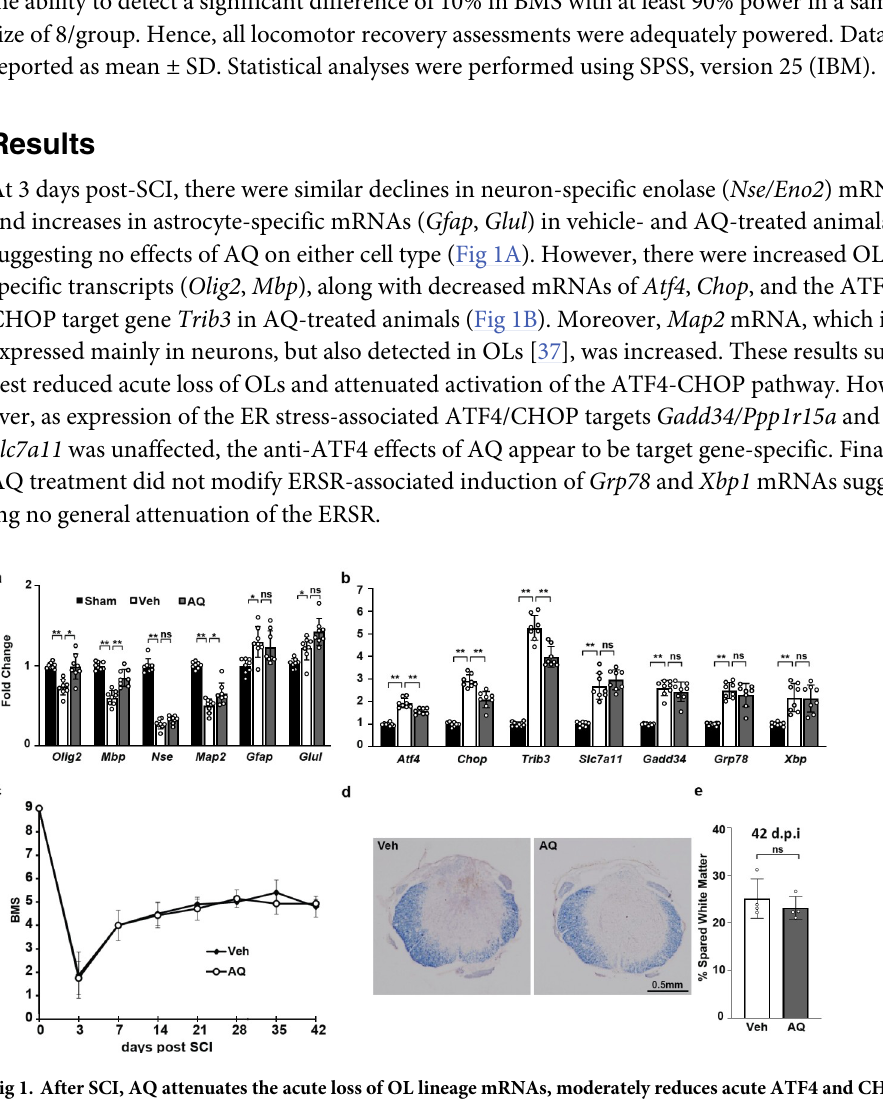
Fig 1. After SCI, AQ attenuates the acute loss of OL lineage mRNAs, moderately reduces acute ATF4 and CHOP activation, but does not improve chronic functional locomotor recovery. (a) neural cell-specific and (b) ISR/ERSR and ATF4-regulated gene mRNA levels 72 hours-post SCI. Transcript levels (normalized to Gapdh ) are expressed as fold change sham controls. Data in (a, b) are the mean ± SD (n = 8, � p < 0.05; �� p < 0.01; ns, p > 0.05, u -test). (c) BMS analysis of hindlimb locomotion revealed no significant differences in hindlimb locomotor recovery between vehicle (Veh)- (n = 6) and AQ-treated 30 mg/kg (n = 7) mice (repeated measure two-way ANOVA showed significant effects of time after injury /F 5,21 = 12.34; p < 0.001/ but no significant effects of treatment /F 1,59 = 0.03; p > 0.05/ or the interaction between time after injury and treatment /F 5,21 = 0.97, p > 0.05/; see S3 Table for raw BMS data). (d) Representative images of the injury epicenter stained with EC to identify myelin (6 weeks post-SCI) (e) Quantitative analysis of EC-stained sections through the injury epicenter shows similar extent of spared white matter. Data are the mean ± SD (n = 4, p > 0.05, u